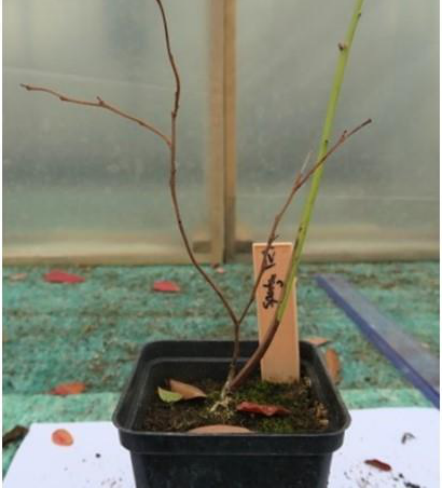
Figure 2. Spread of necrosis on highbush blueberry plant ‘Spartan’ 10 months after infection with P. cinnamomi.